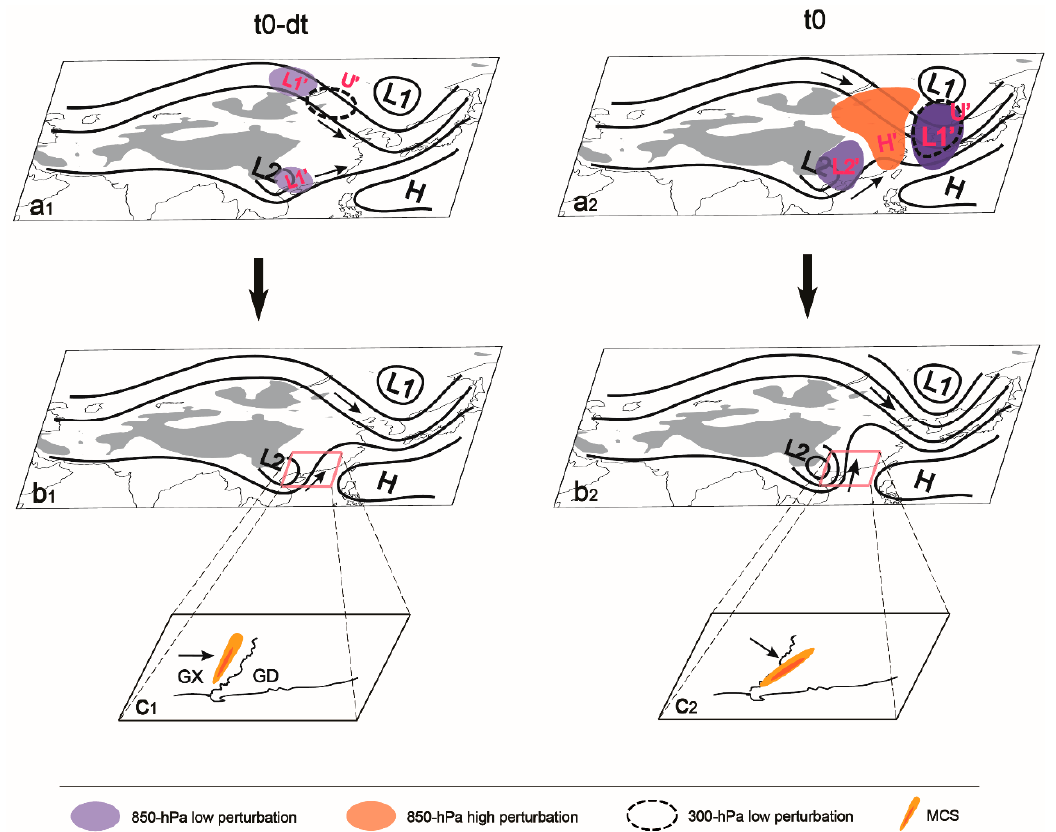
Figure 13. Schematic illustration of how ( a 1 – a 2 ) the evolution of SSTA (color-shaded) and climatic average (contours) of geopotential height impact ( b 1 – b 2 ) that of the complete geopotential height field (contours) at low levels, which promoted warm-sector MCSs to move suddenly from ( c 1 ) eastward/northeastward to ( c 2 ) southeastward when they entered Guangdong (GD) province from Guangxi (GX) province. “L” and “H” indicate the low and high value centers of geopotential height, respectively, while “L1’/L2’/U’” and “H’” indicate the low and high SSTA-GHs, respectively. The arrows indicate the ( a 1 – a 2 and b 1 – b 2 ) flows or ( c 1 – c 2 ) MCS motion directions.